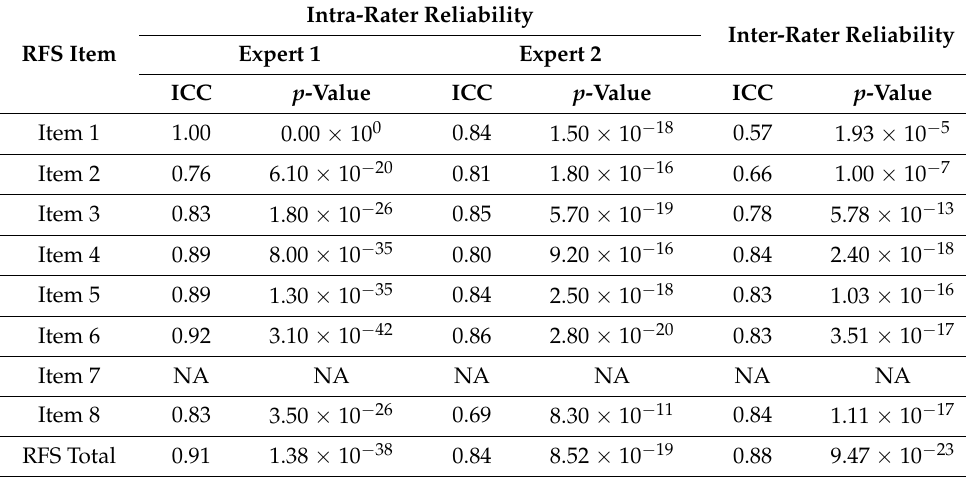
Table 6. Reliability of the PL-RFS